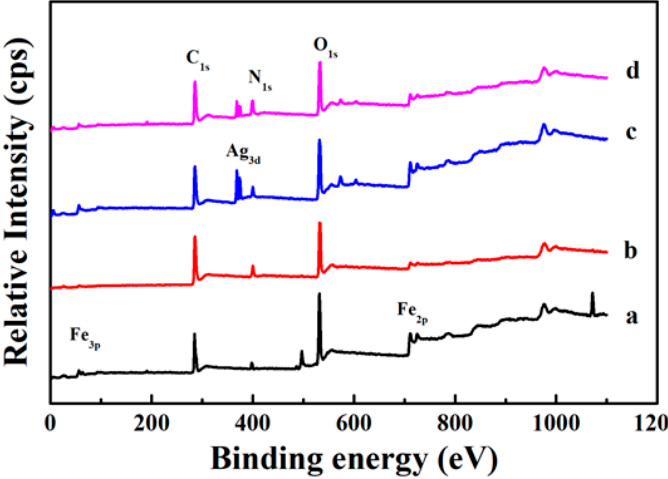
Figure 7. XPS spectra of the as-prepared samples Fe 3 O 4 ( a ), Fe 3 O 4 @PDA ( b ), Fe 3 O 4 @PDA / Ag ( c ), and Fe 3 O 4 @PDA / Ag / PDA ( d ) nanospheres.